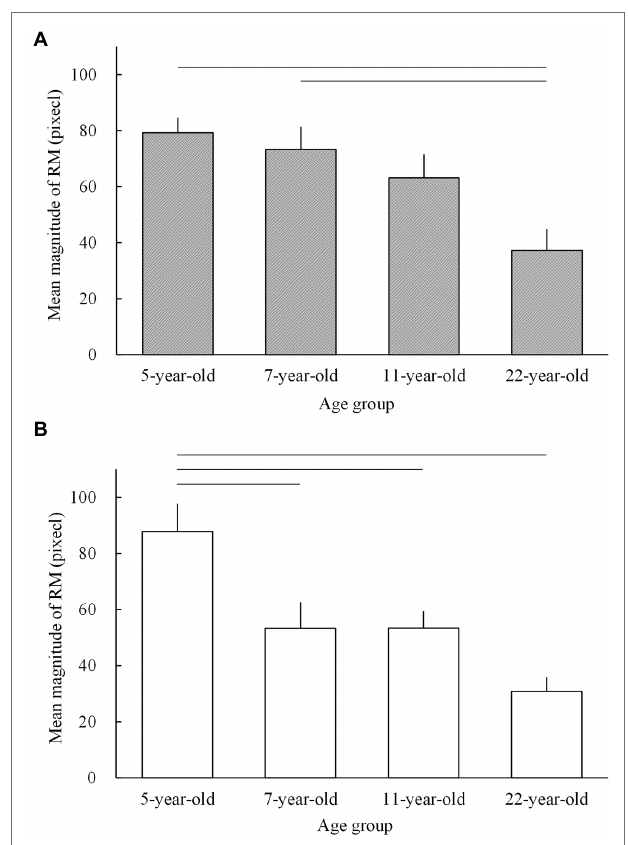
FIGURE 5 | The mean magnitudes of representational momentum (RM) for 5-year-old children from the present study and 7- and 11-year-old children and 22-year-old adults from the Shirai et al. (2018) study in (A) the pointing task and (B) the judging task. The horizontal lines indicate significant differences ( p < 0.05; see the text for the respective p values). The error bars present 1 standard